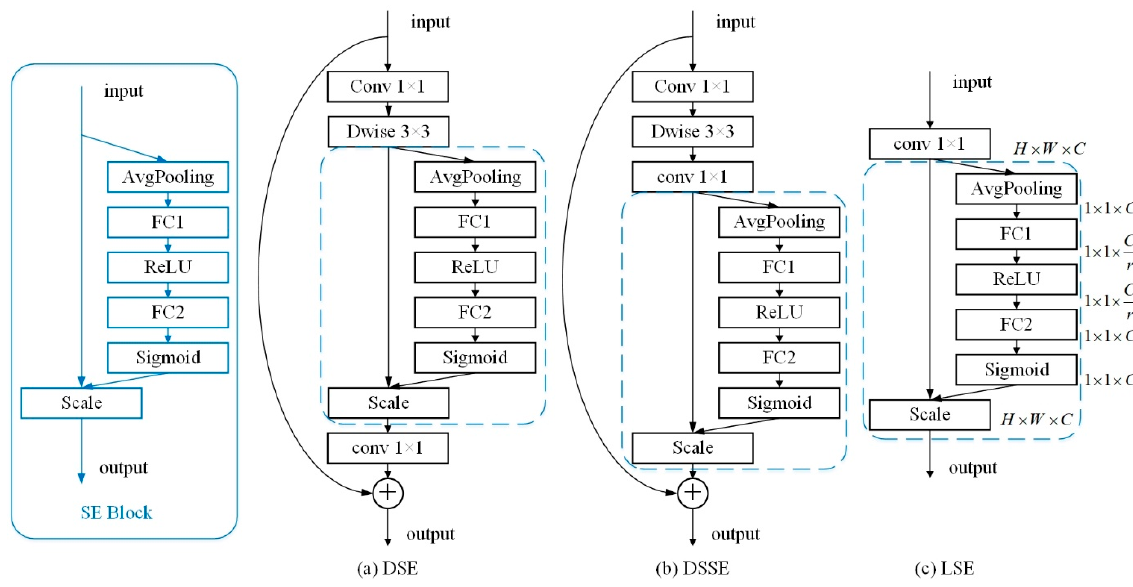
Figure 3. SE block (in the blue box) and three improved structures based on the channel attention mechanism. ( a ) depthwise SE (DSE) module, ( b ) depthwise separable SE (DSSE) module, ( c ) linear SE (LSE) module. Conv with capital letter represents a convolution module with a nonlinear activation function PReLU and the BN layer. Conv without capital letter represents the convolution module that does not use a nonlinear activation function. Dwise represents the depthwise